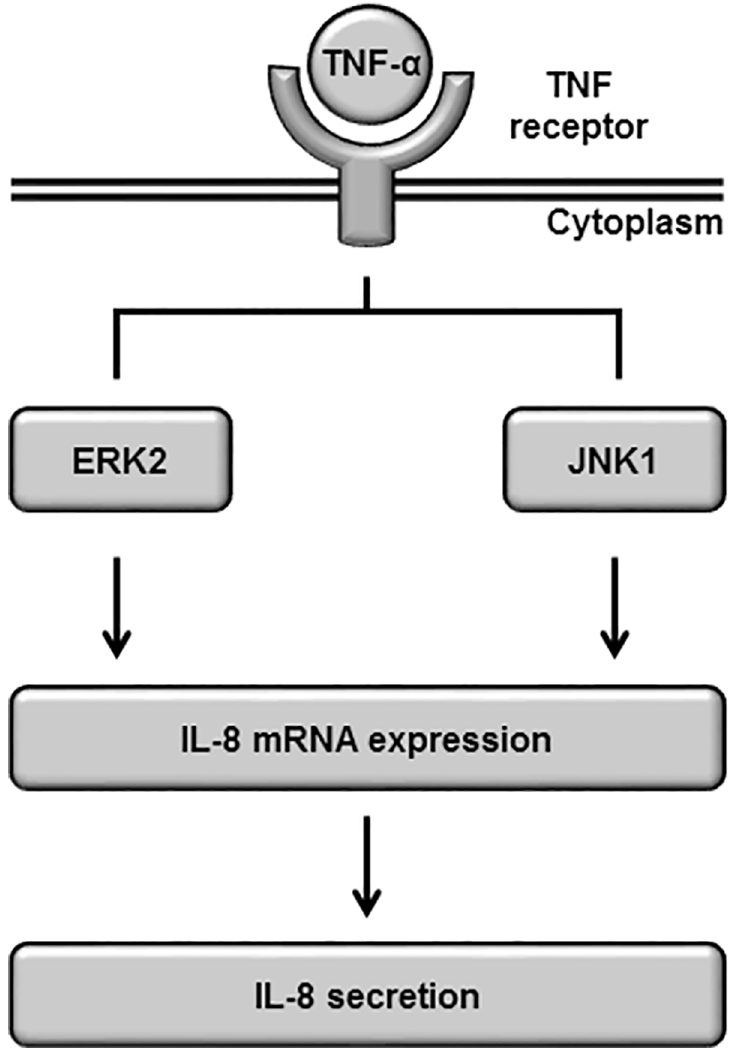
Fig 6. Schematic diagram of the contribution of ERK2 and JNK1 activation to TNF- α -induced IL-8 expression in synovial fibroblasts. In TNF- α -stimulated synovialfibroblasts, ERK2 and JNK1 cooperatively lead to the activationof IL-8 expression, without ERK1 and